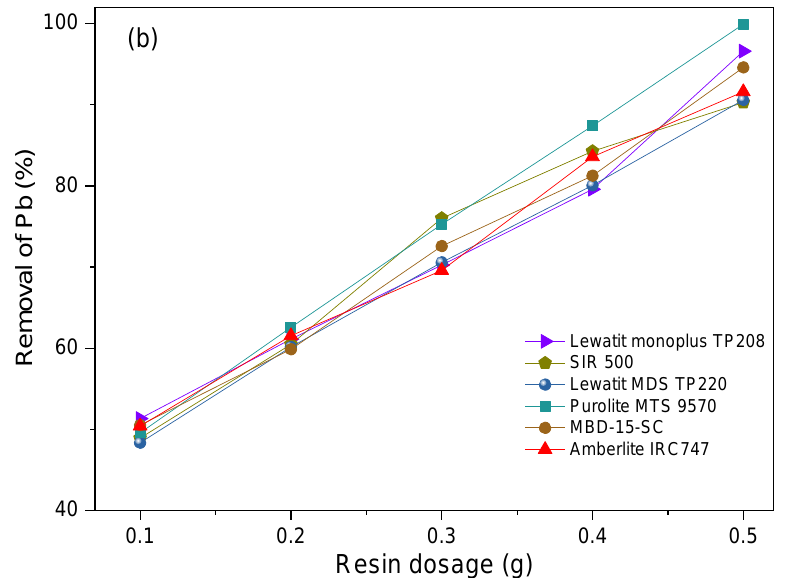
Figure 1. Resins with high removal rate of Pb (II) at 30 min contact time, 150 rpm agitation speed, 20 mL volume, pH 4.5, concentration 1000 mg/L, and temperature 20 °C. (a ) Purolite S940, Lewatit monoplus TP207, Amberlite IR-120H, Dowex G-26, Purolite S930 plus, Amberlite IRC7841, and Purolite S950 plus resin. ( b ) Lewatit monoplus TP208, SIR 500, Lewatit MDS TP220, Purolite WTS 9570, MBD-15-SC, and Amberlite IRC747 resin.